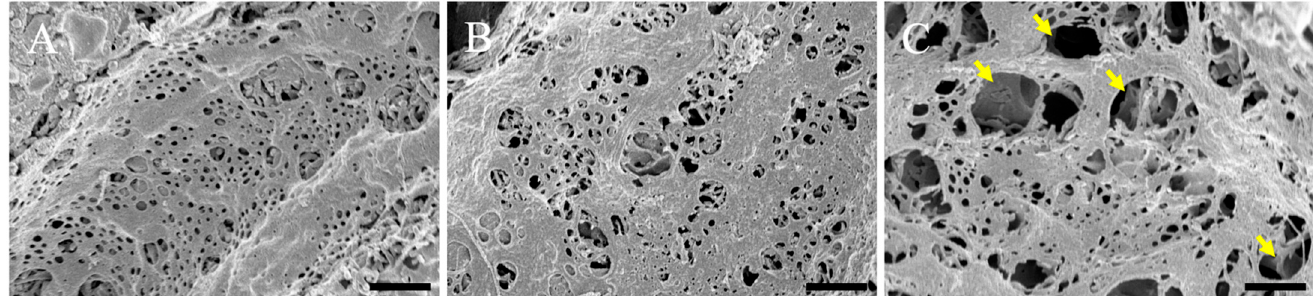
Figure 3. Scanning electron microscopy micrographs of the sinusoidal endothelium are shown. The sinusoidal endothelium of the control is shown ( A ). ( B , C ) Sinusoidal endothelium of animals, 3 h and 24 h post-ammonia treatment, respectively. Yellow arrows show the swelling of sinusoidal fenestrations. All scale bars = 1 µm.